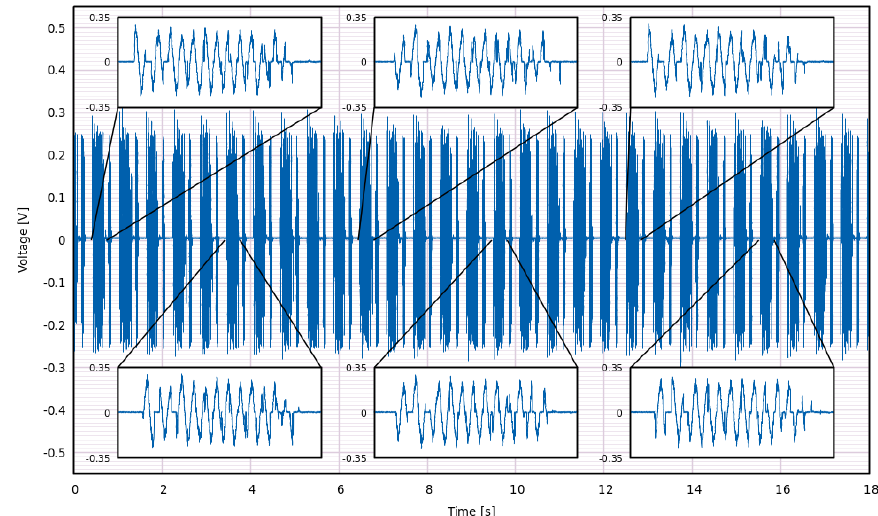
Figure 8. Voltage waveform generated by sample B-75 under R LOAD = 6.11 M Ω upon repeated actuation under test conditions. Insets show waveforms of single subsequent actuations. The length of a single displayed waveform is 0.5 s and the start points between subsequent actuations are separated by 0.61